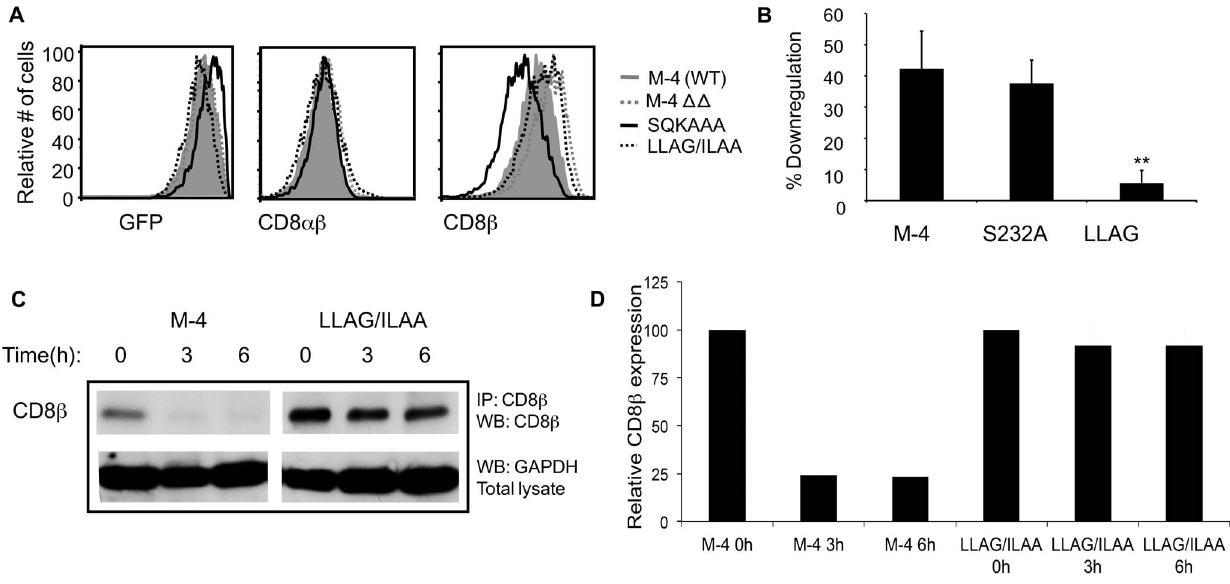
Figure 3. Di-leucine motif in the cytoplasmic tail of M-4 isoform regulates cell surface expression. ( A ) Histograms showing expression of GFP, CD8 ab heterodimer and total CD8 b for M-4 wildtype and mutant proteins analyzed in JM thymoma by flow cytometry . ( B ) Percentage downregulation of total CD8 b in JM expressing M-4 wild type or mutant proteins after stimulation relative to unstimulated cells. ( C ) Stability studies of CD8 b M-4 wild-type and mutants. JM cells treated with cycloheximide, lysed and immunoprecipitated with anti-CD8 b antibody were resolved on SDS-PAGE, transferred to a nitrocellulose membrane and probed with anti-CD8 b mAb (5F2). A portion of the total cell lysate was analyzed by Western blotting with GAPDH mAb. ( D ) The CD8 b protein level was determined by quantitating the band intensity for each CD8 b band and plotting the mount relative to the protein amount at time zero for three independent experiments.